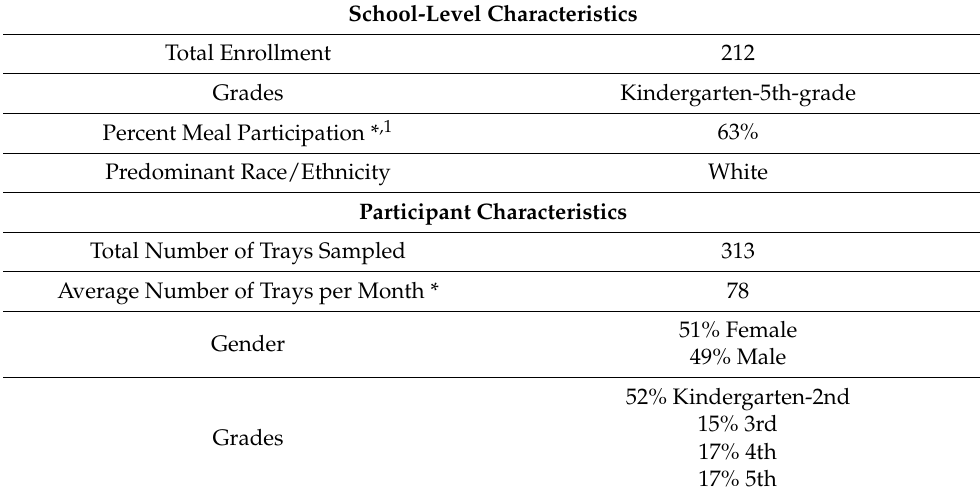
Table 1. Student-level and participant-level demographic characteristics of intervention